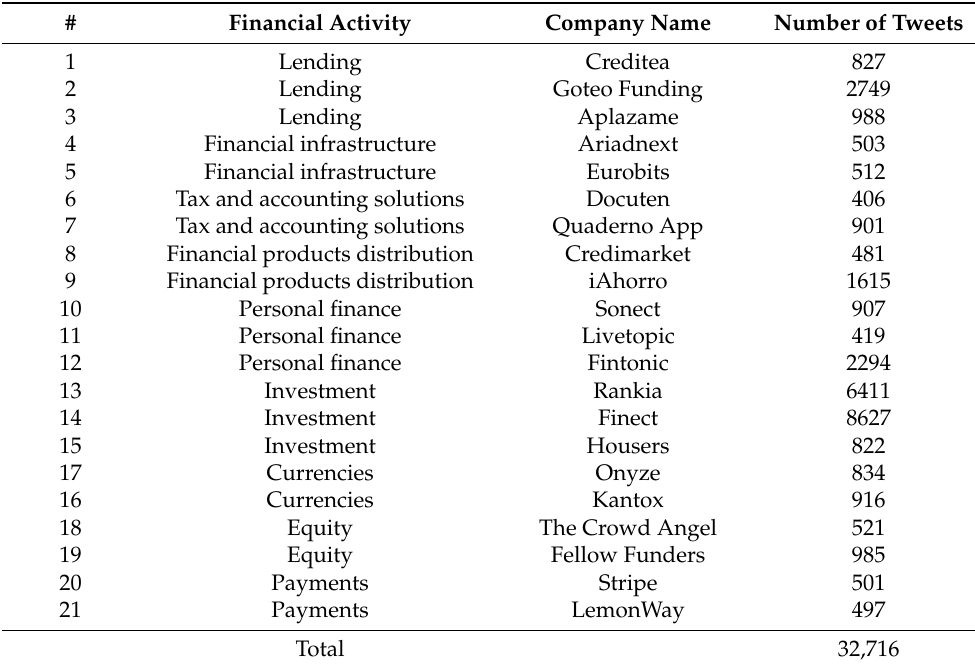
Table 1. The 21 FinTech companies selected based on their Twitter